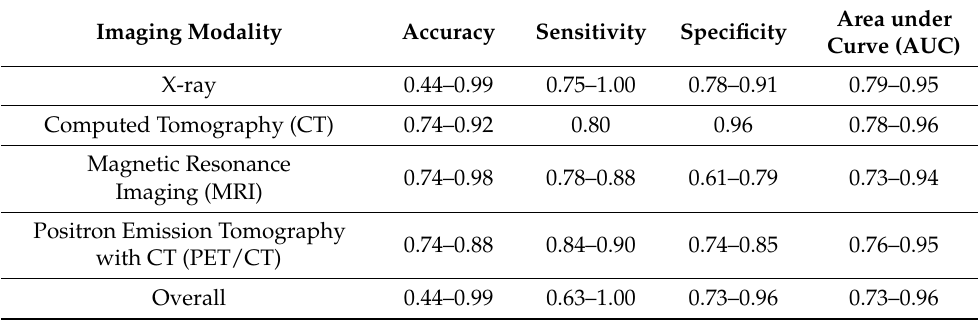
Table 2. The performance of Artificial intelligence among various imaging modalities in distinguish- ing benign vs. malignant bone